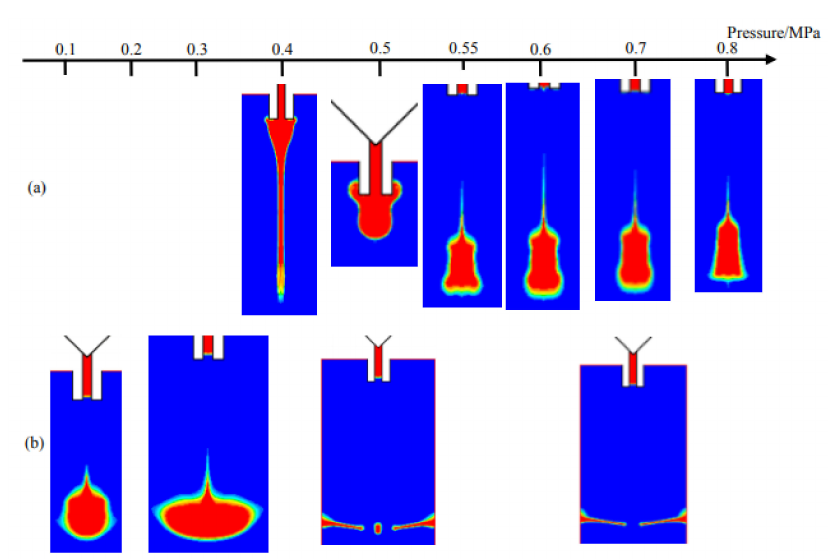
Figure 6. Simulation results from changes in pressure when viscosity is ( a ) 1000 mPa · s; ( b ) 100 mPa ·